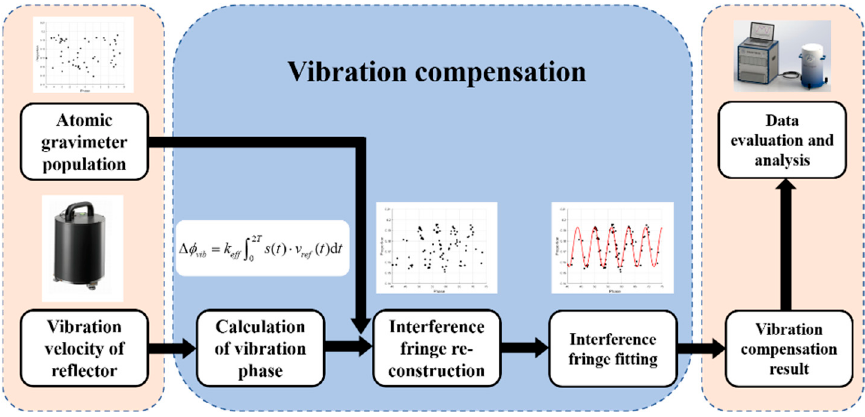
Figure 1. Principles of vibration compensation.